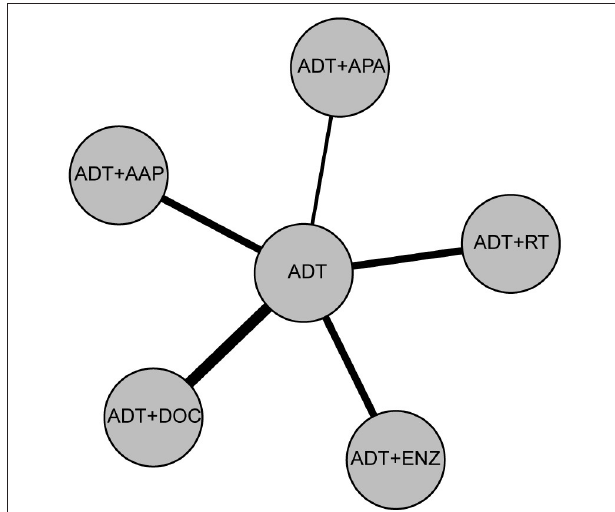
FIGURE 3 | Network plot of six treatment modalities. For OS, PSA-PFS, and Gleason score < 8/ ≥ 8, low/high volume subgroups, ADT monotherapy, ADT + APA, ADT + AAP, ADT + DOC, ADT + ENZ, and ADT + RT were compared. For time to SSE and time to pain progression, ADT + APA, ADT + AAP, ADT + ENZ, and ADT monotherapy were compared. For time to chemotherapy, ADT + APA, ADT + AAP, and ADT monotherapy were compared.